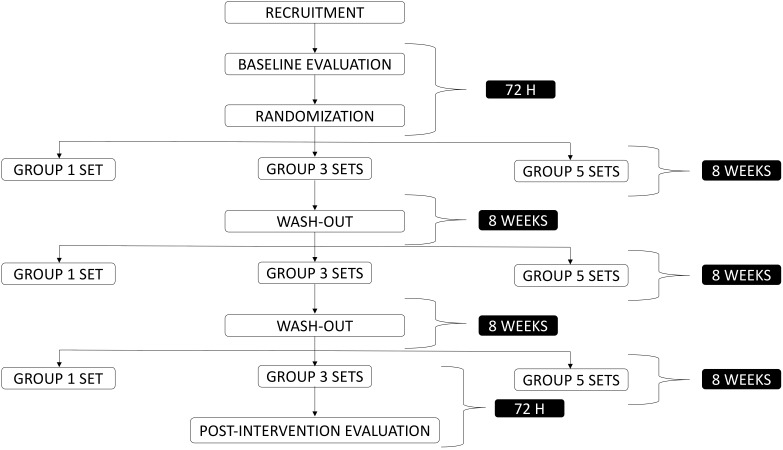
Experimental design of the investigation.